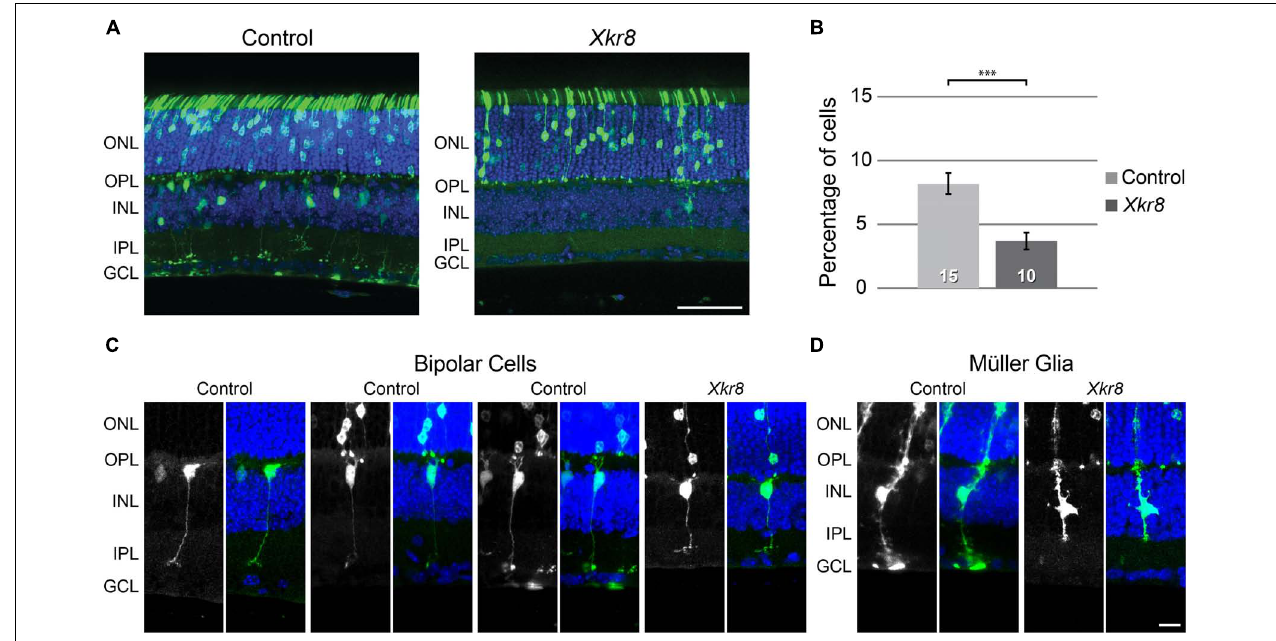
FIGURE 7 | (A) Electroporation of control plasmids on P2 yielded GFP-positive cells occupying the ONL and INL, consistent with the postnatal genesis of rod photoreceptor, bipolar, Müller glial, and amacrine cell populations. (B) We quantified all GFP-positive cells in the section and determined the proportion situated in the outer half of the INL, where bipolar cell populations are resident. Electroporation of Xkr8 encoding plasmids produced a reduction in the frequency of GFP-positive cells in the outer INL. The frequency of GFP-positive cells in this bipolar cell stratum is halved relative to the control plasmid condition ( ∗∗∗ p < 0.001). n = the number of retinas examined in each condition. The labeled cells were commonly identifiable by their morphology, with bipolar cells being found in the outer half of the INL (C) . Muller glia, being positioned at a mid-depth in the INL (D) , were usually slightly more vitreal in their positioning in the INL, and would therefore not be included in counts of cells situated in the bipolar cell stratum. Scale bar = 50 µ m for (A) ; = 10 µ m for (C,D) .